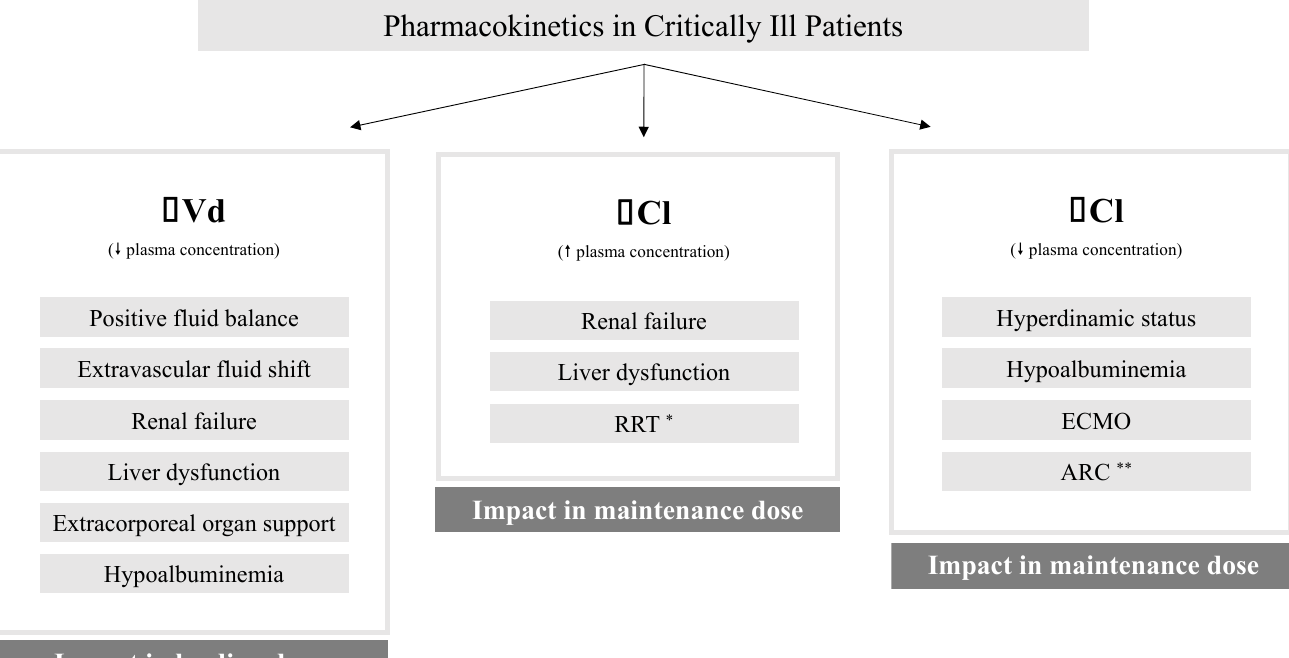
Figure 3. Main pharmacokinetic changes of β -lactam antibiotics in critically ill patients. * Especially common in drugs with high volumes of distribution (>1 L/Kg) or high protein binding (>80%); ** More common in young males with trauma, sepsis, burns, hematological malignancy, or pancreati-